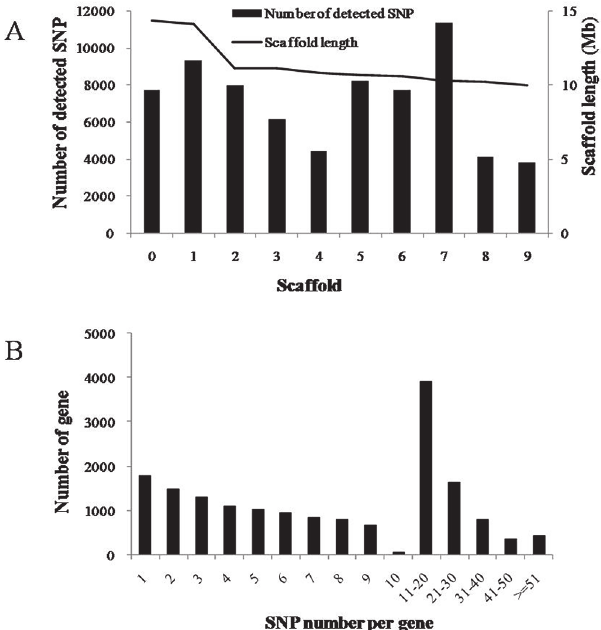
Fig 3. SNP distribution among scaffolds and genes. (A) Distribution of expressed SNPs on the top ten scaffold. (B) Number of SNP per gene.